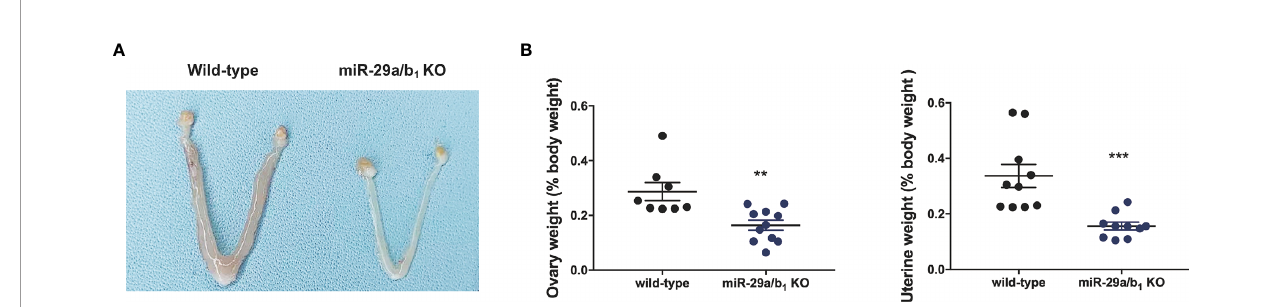
FIGURE 2 | Morphological study of reproductive system. (A, B) Macroscopic images, wet ovaries and uteri weight in females, normalized to body weight in the same animals (ovary: wild-type: 0.2868 ± 0.03286, n=8, miR-29a/b 1 KO: 0.164 ± 0.01834, n=11, p=0.0028 ; uteri: wild-type: 0.3369 ± 0.04175, miR-29a/b 1 KO: 0.1564 ± 0.01394, p=0.007 , n=10). ** p < 0.01, *** p < 0.001.